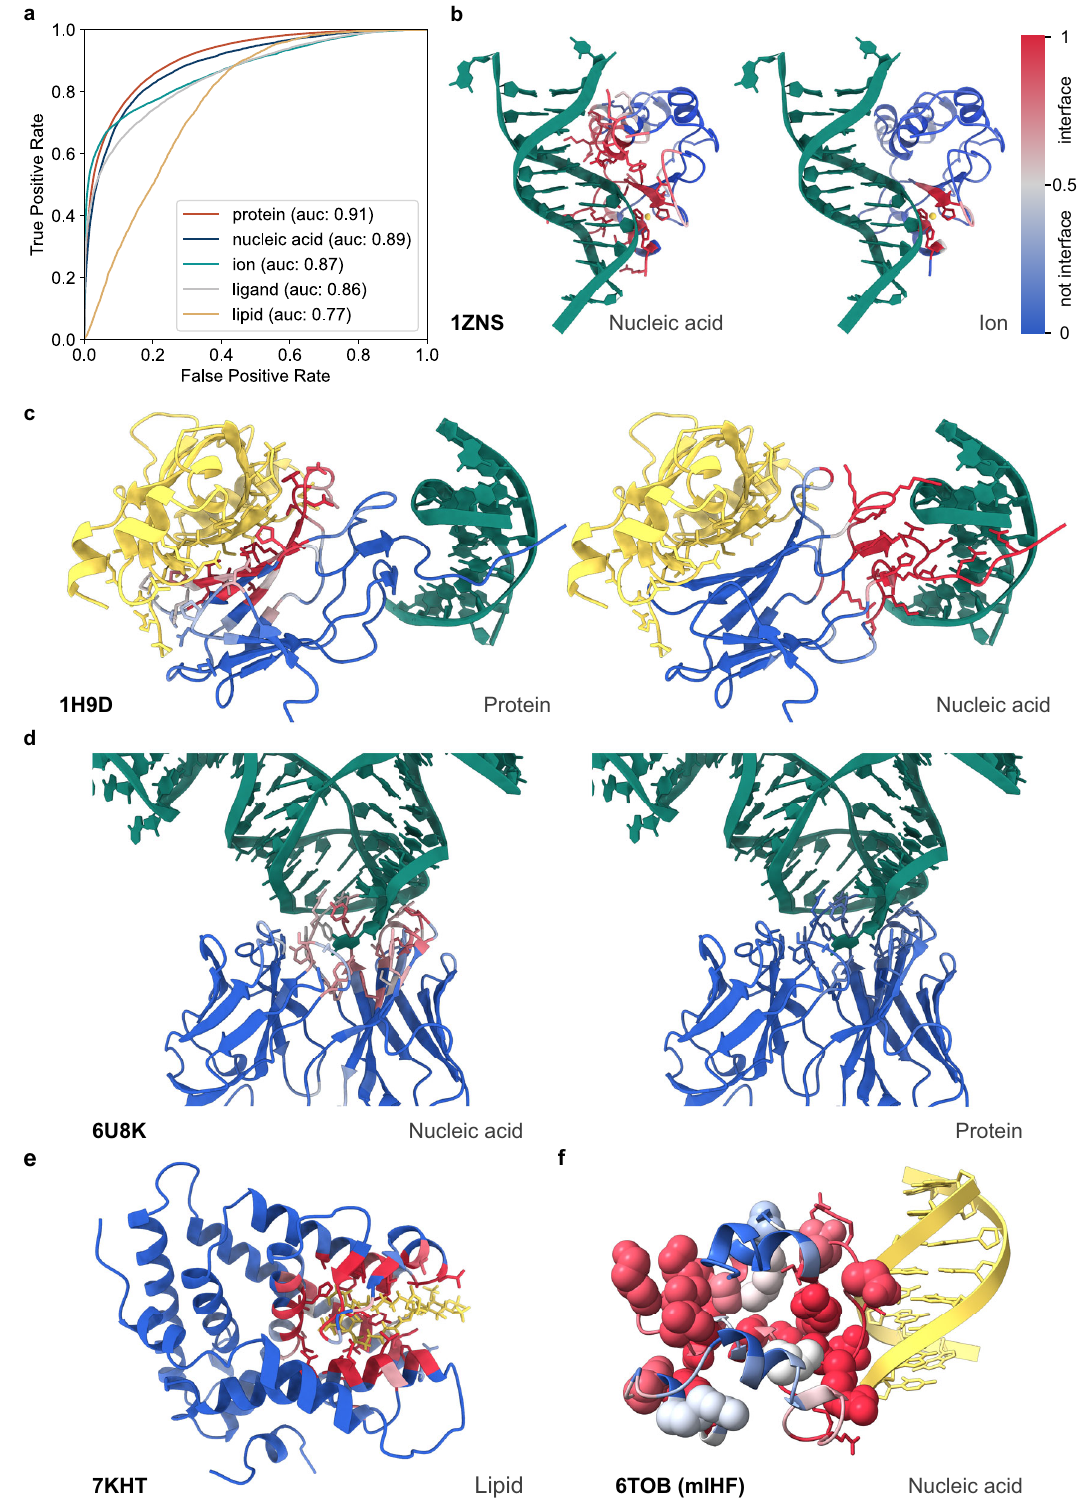
Fig.3|GeneralproteinbindinginterfacepredictionwithPeSTo.a ROCcurvefor the predictions of different types of interfaces with PeSTo. ( b – f ) Examples of pre- dicted binding interfaces. The con fi dence of the predictions is represented with a gradient of color from blue for non-interfaces to red for interfaces. The structures in yellow and green were added subsequently from the reference complexes. b ColicinE7endonucleasedomainincomplexwithDNAandazincion(PDB:1ZNS). c core-biding factor subunit alpha-2 in complex with core-binding factor subunit